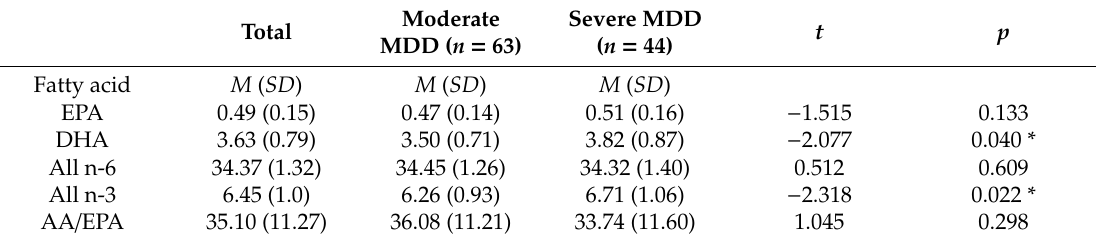
Table 2. Fatty acid status for moderately and severely depressed